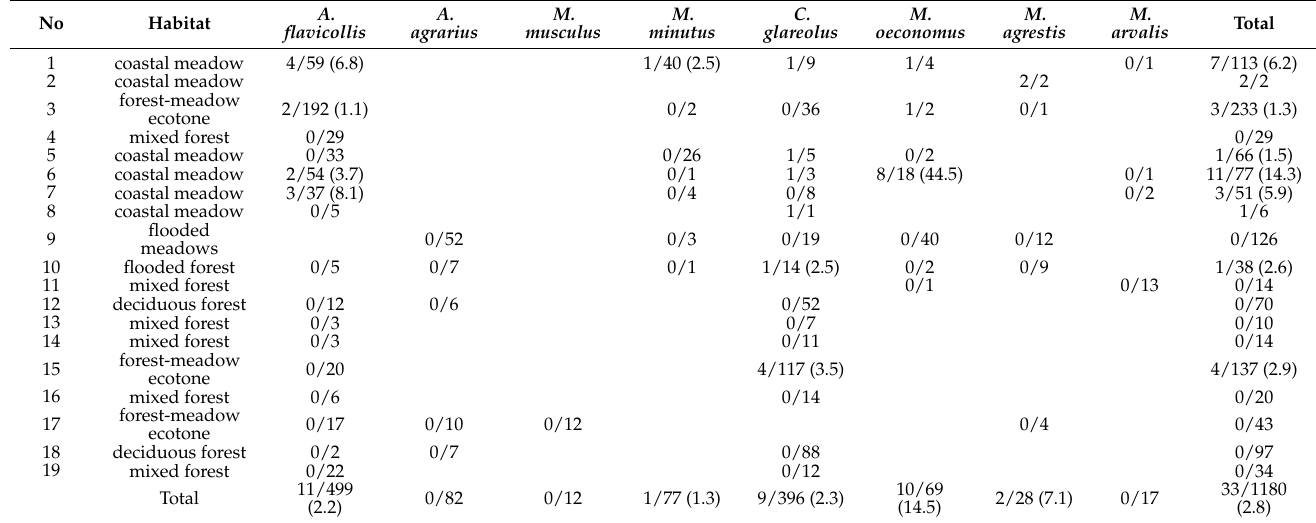
1 n, number of individuals infected; N, number of individuals tested; No, site